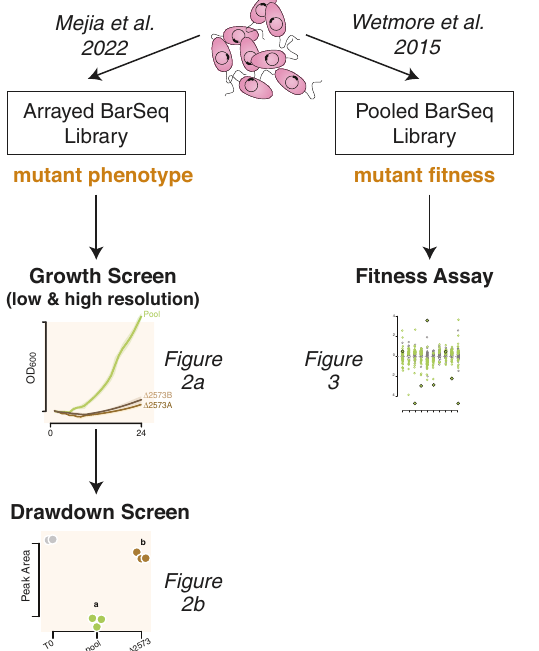
Fig. 1 Experimental fl ow chart for the R. pomeroyi RB-TnSeq library. Right path: Pooled mutant populations (pooled-RB-TnSeq library) are used for gene fi tness assays. Left path: Individual transporter mutants from the library (arrayed-RB-TnSeq library) are used to screen for growth and metabolite drawdown.